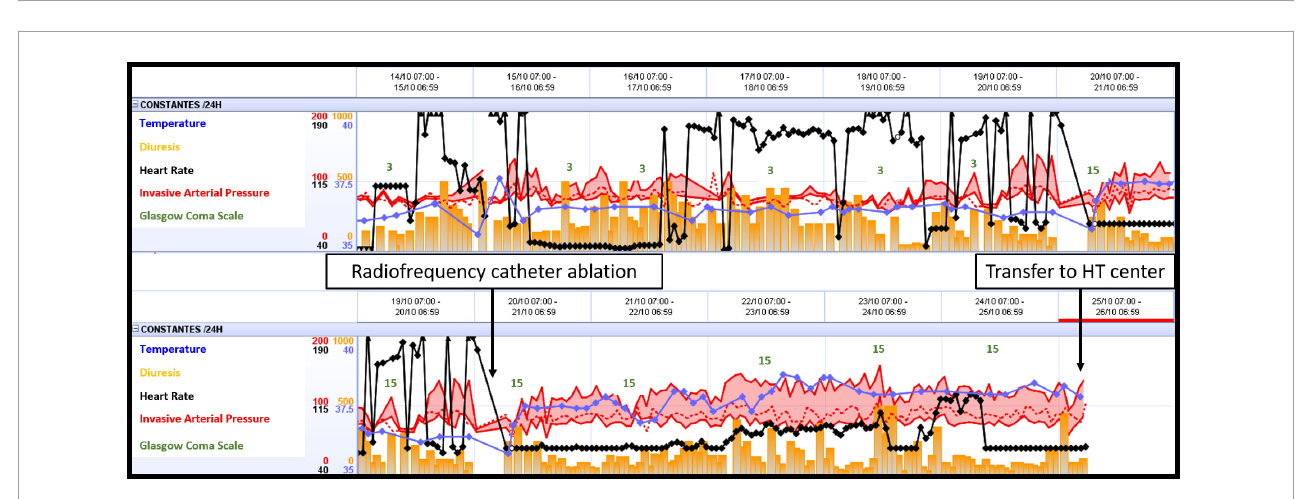
FIGURE2 Time course of hemodynamic and neurologic parameters in the ICU while on ECMELLA. ECMELLA, combination of extracorporeal membrane oxygenation and Impella; HT, heart